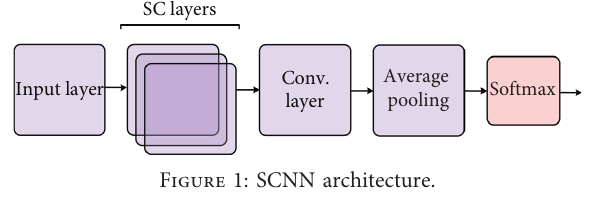
Figure 1: SCNN architecture.